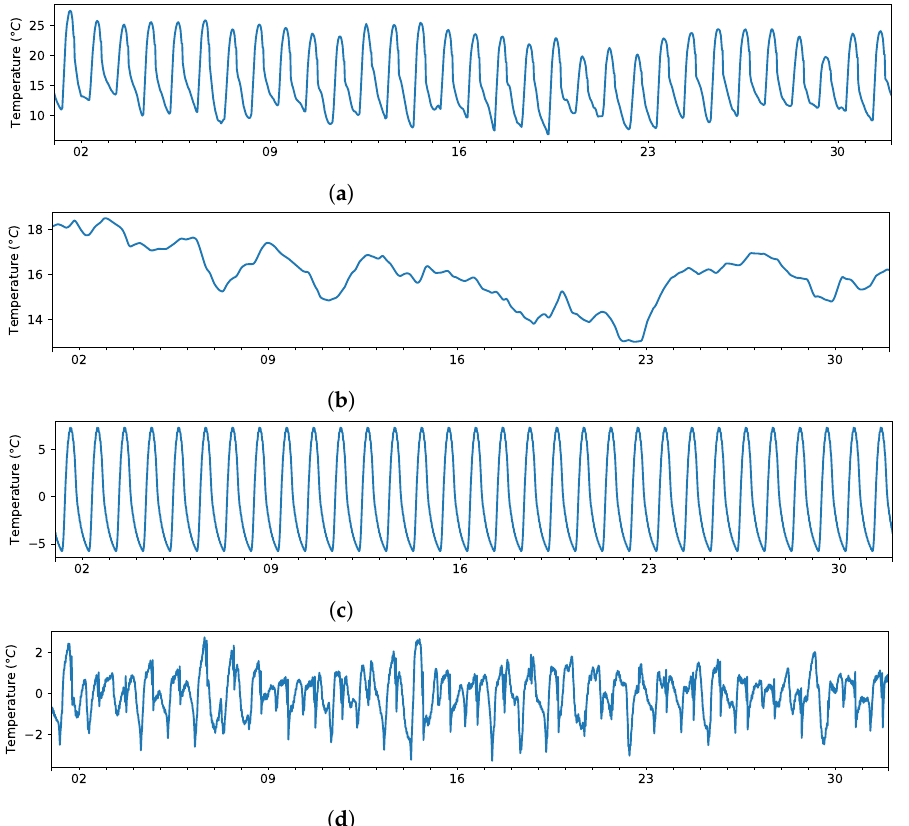
Figure 9. Temperature time series decomposition. ( a ) Observed values. ( b ) Trend component. ( c ) Seasonal component. ( d ) Residual